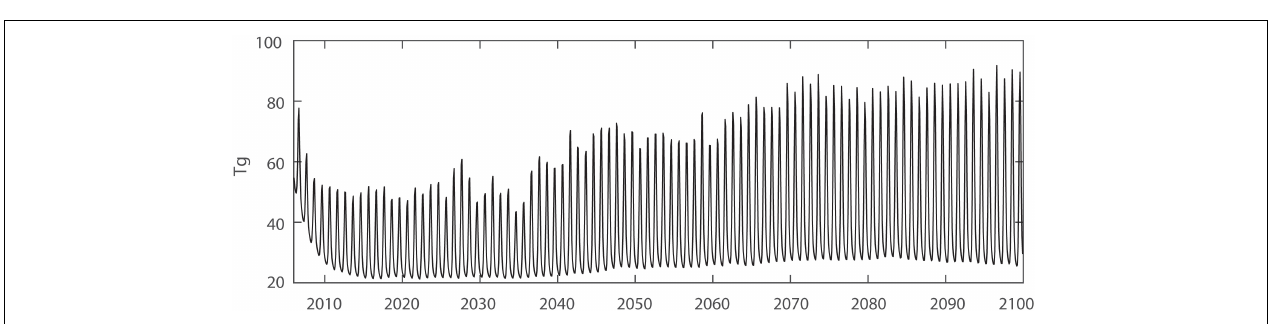
FIGURE 3 | Development of total inorganic carbon in the Arctic Ocean the 21st century for two climatic scenarios.